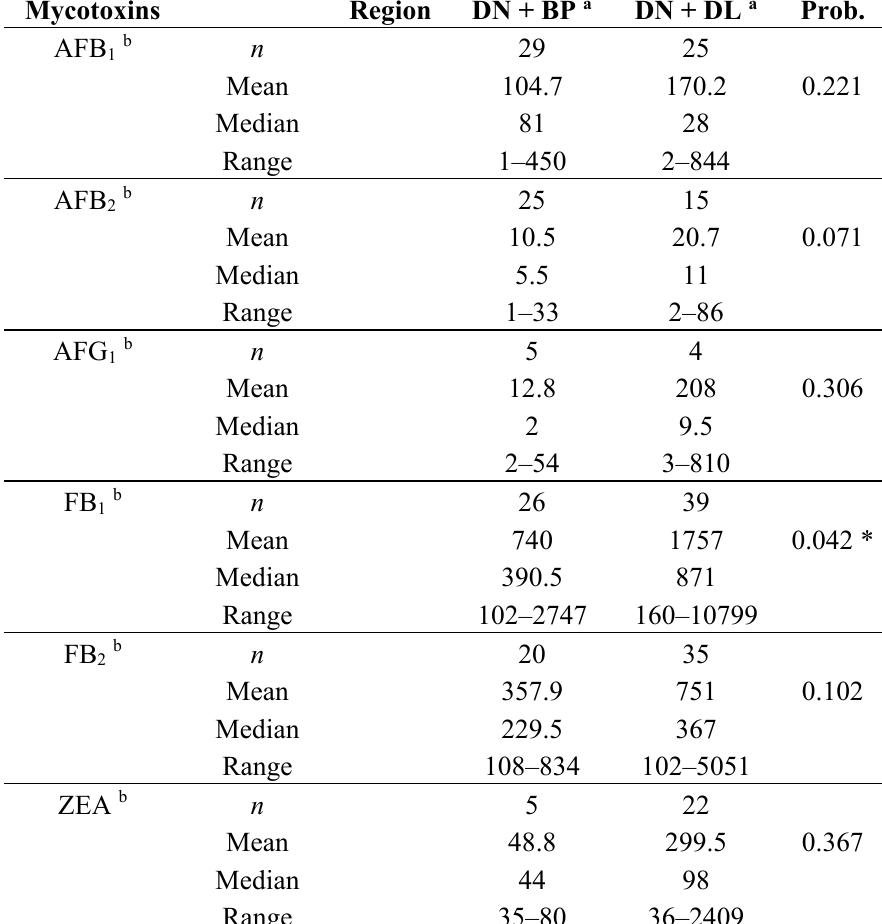
Table 2. Aflatoxins, fumonisins and zearalenone levels ( μ g/kg) in maize from the Southeast Mekong Delta Uplands and Central Highlands of